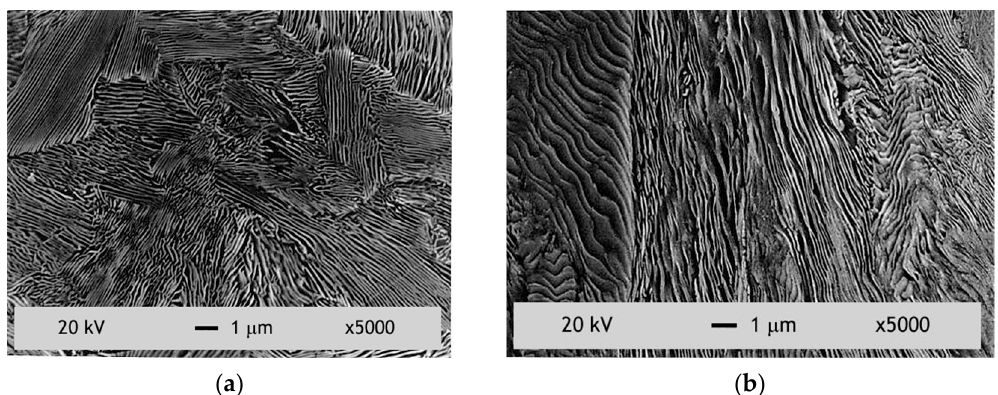
Figure 1. Longitudinal metallographic sections of hot-rolled pearlitic steel 0 ( a ) and cold-drawn pearlitic steel 6 ( b ). In both cases, the vertical side of the micrographs corresponds to the wire axis or cold-drawing direction.